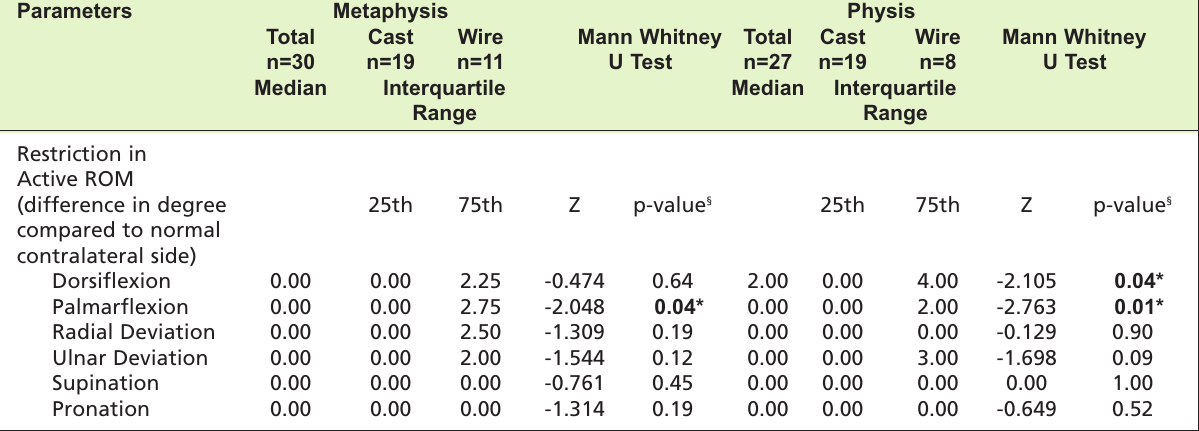
Comparison of restriction in active ROM between cast and wire in metaphysis and physis groups Table IV: Parameters